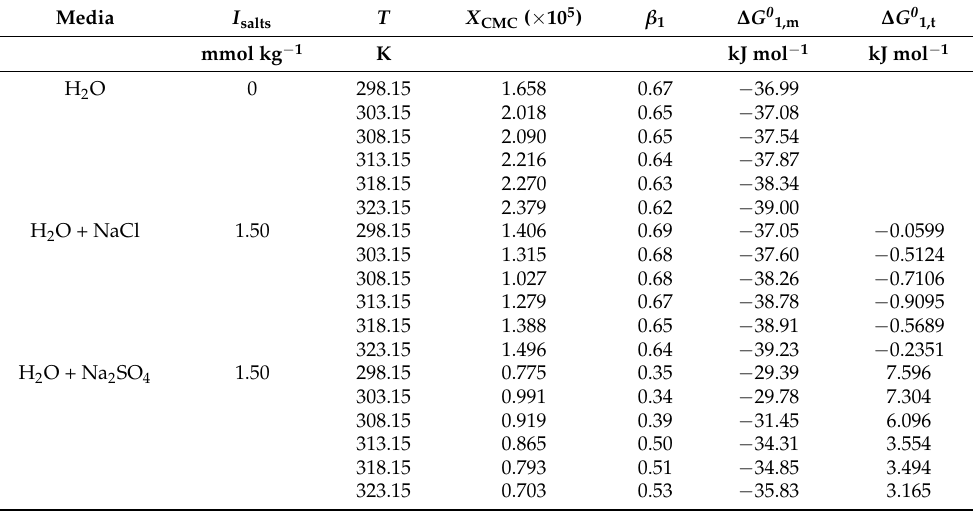
Table 4. Values of β 1 , free energy change ( ∆ G 0 1, m ), and free energy change of transfer ( ∆ G 0 1, t ) for CPC + 0.1% ( w / v ) PVP mixed systems in H 2 O and aq. solution of NaCl/Na 2 SO 4